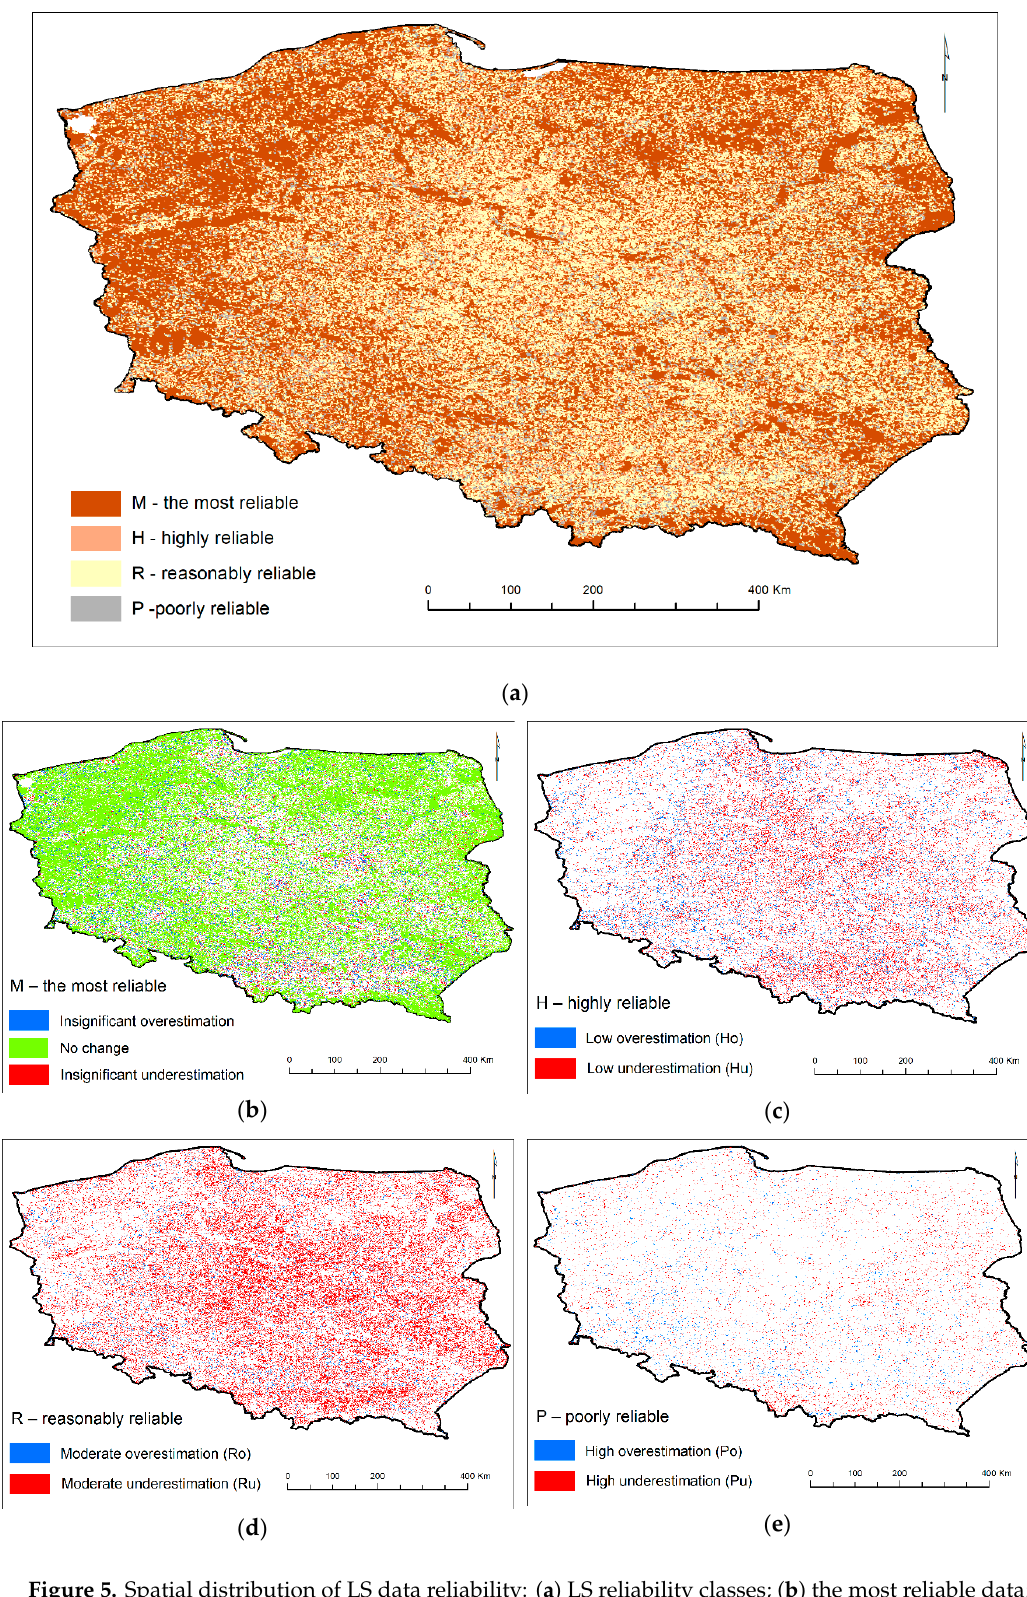
Figure 5. Spatial distribution of LS data reliability: ( a ) LS reliability classes; ( b ) the most reliable data; ( c ) highly reliable data; ( d ) reasonably reliable; ( e ) poorly reliable LS data.